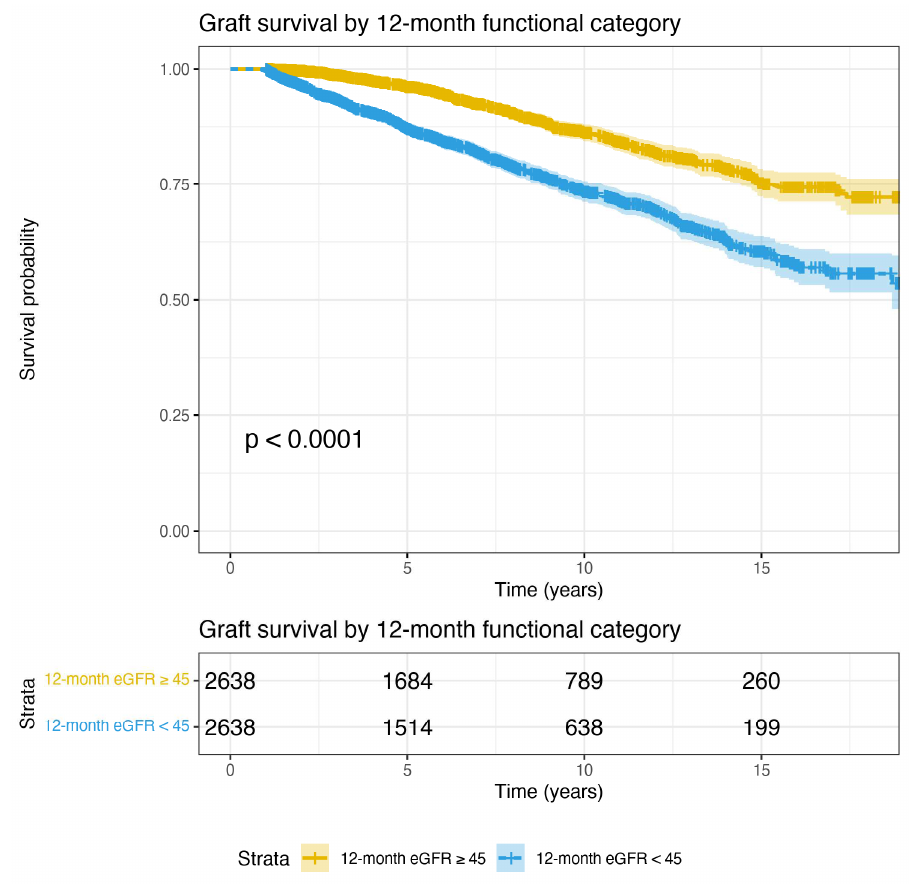
Figure 3. Graft survival curves for the analysis 2 cohort (discordant on 12-month function), up to 18 years post-transplant. 12-month survival is 100% in this case-control study cohort by selection. Again, by design, one kidney from each donor is included in each of the two groups. This figure shows that when donor factors are controlled, 12-month functional category defined using an eGFR cut-off of 45 mL/min is a highly significant predictor of graft survival ( p < 0.0001, log-rank test).